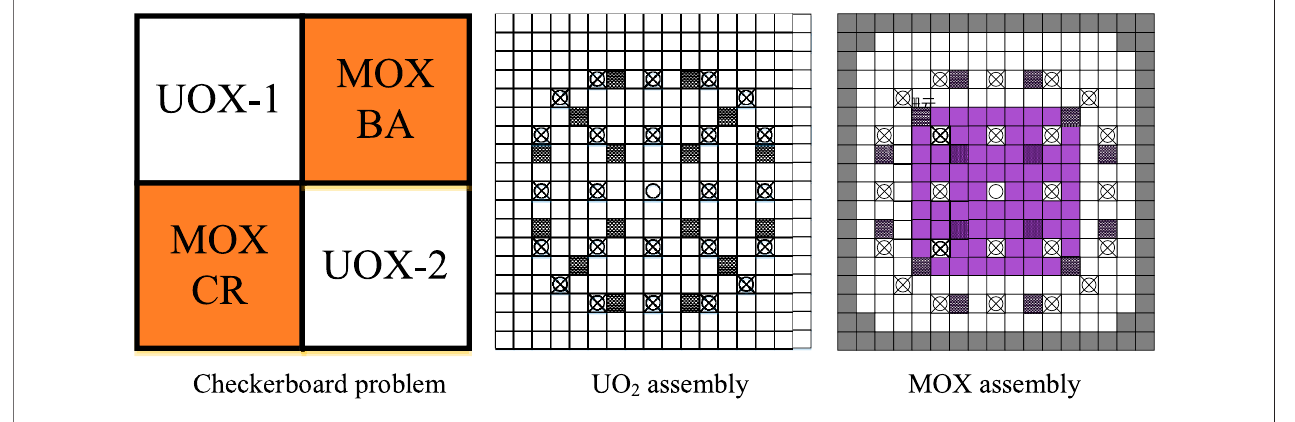
FIGURE 1 | Con fi guration of the checkerboard